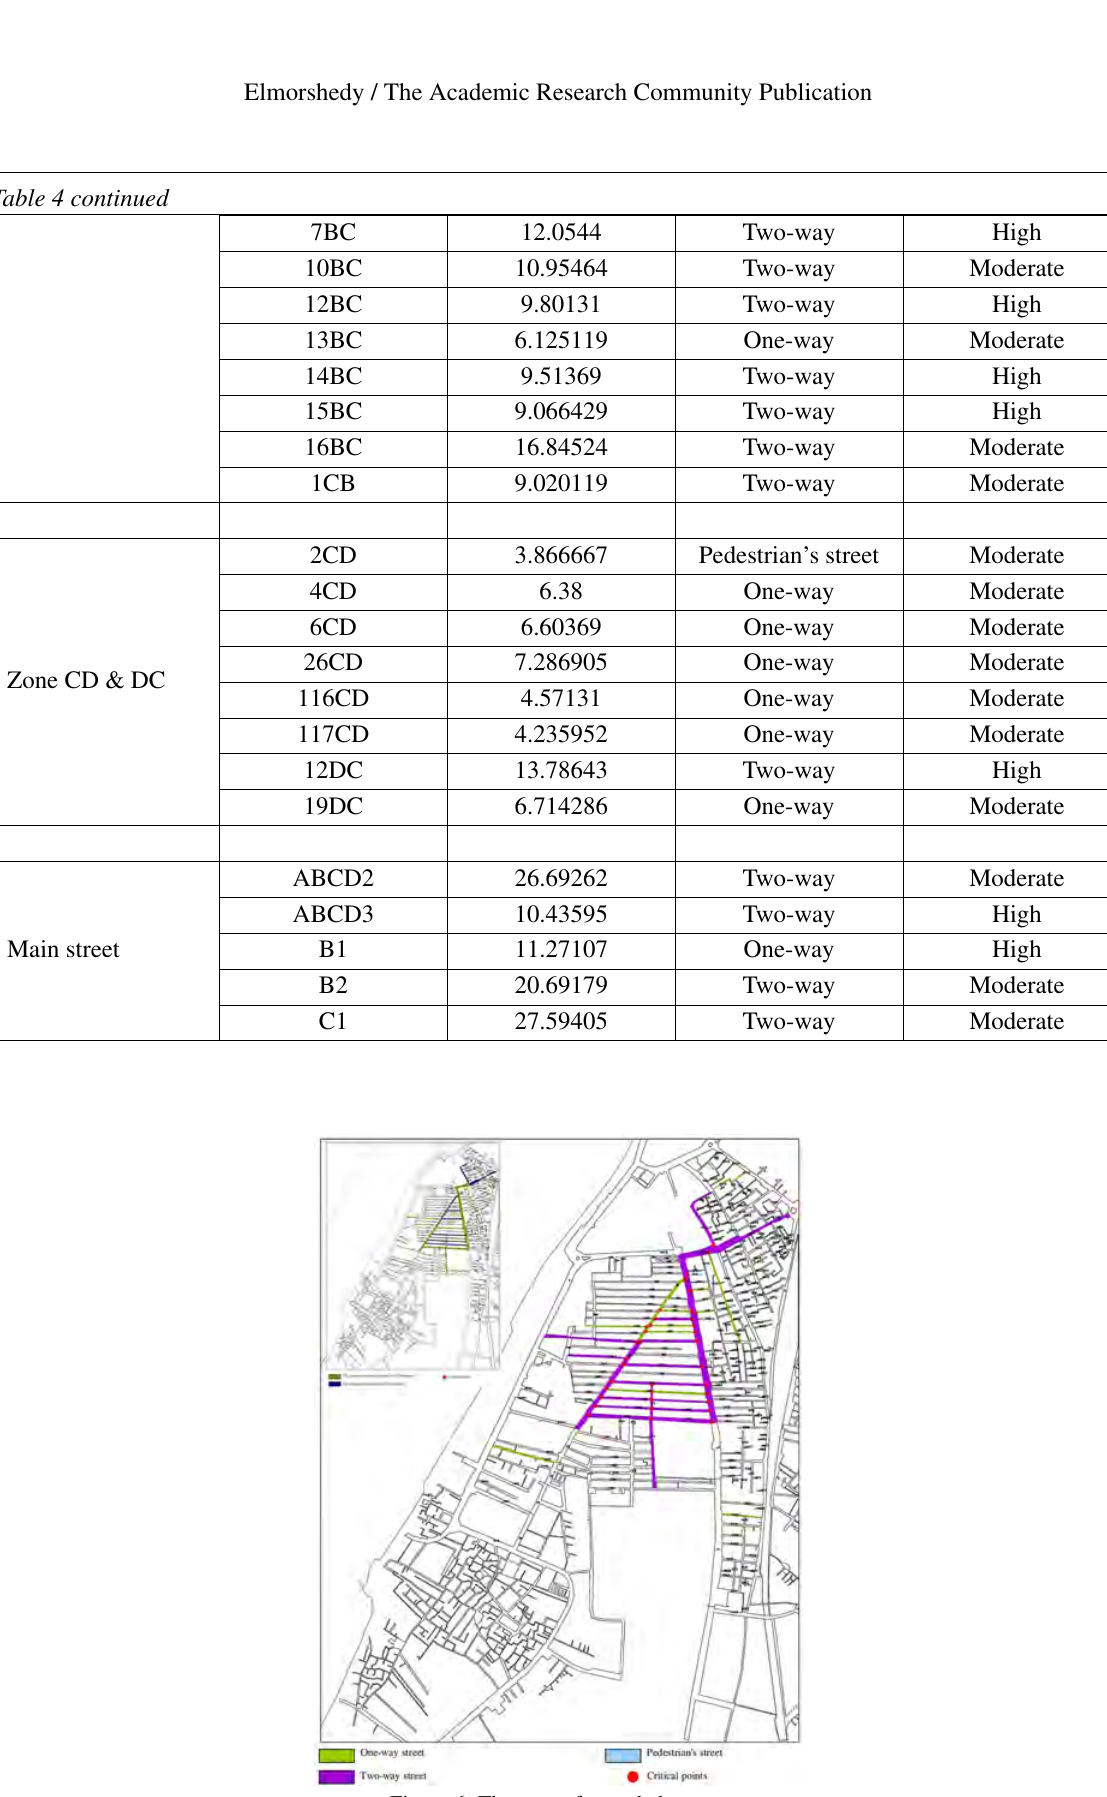
Figure 6. The type of crowded